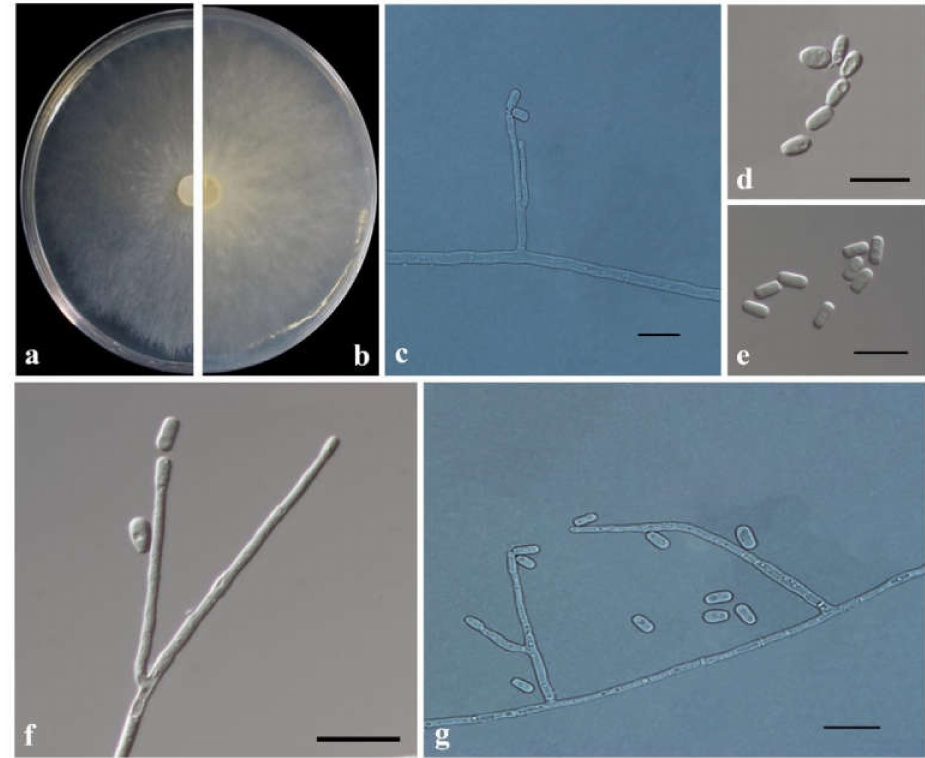
Figure 9. Morphological characteristics of Graphilbum parakesiyea . ( a , b ) Upper and reverse cultures on 2% MEA 8 days after inoculation. ( c – g ) Conidiogenous cells of hyalorhinocladiella-like asexual state and conidia. Scale bars: 10 µ m ( c – g ).